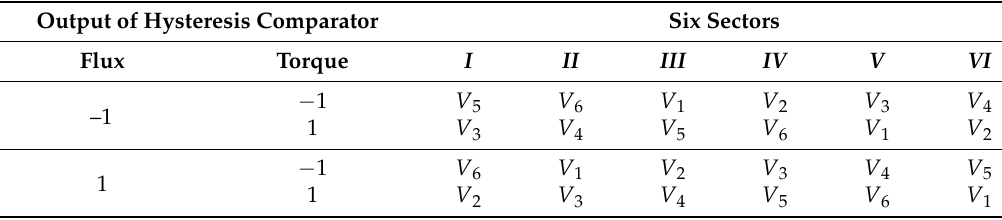
Table 1. Voltage vector switch table (motoring mode).